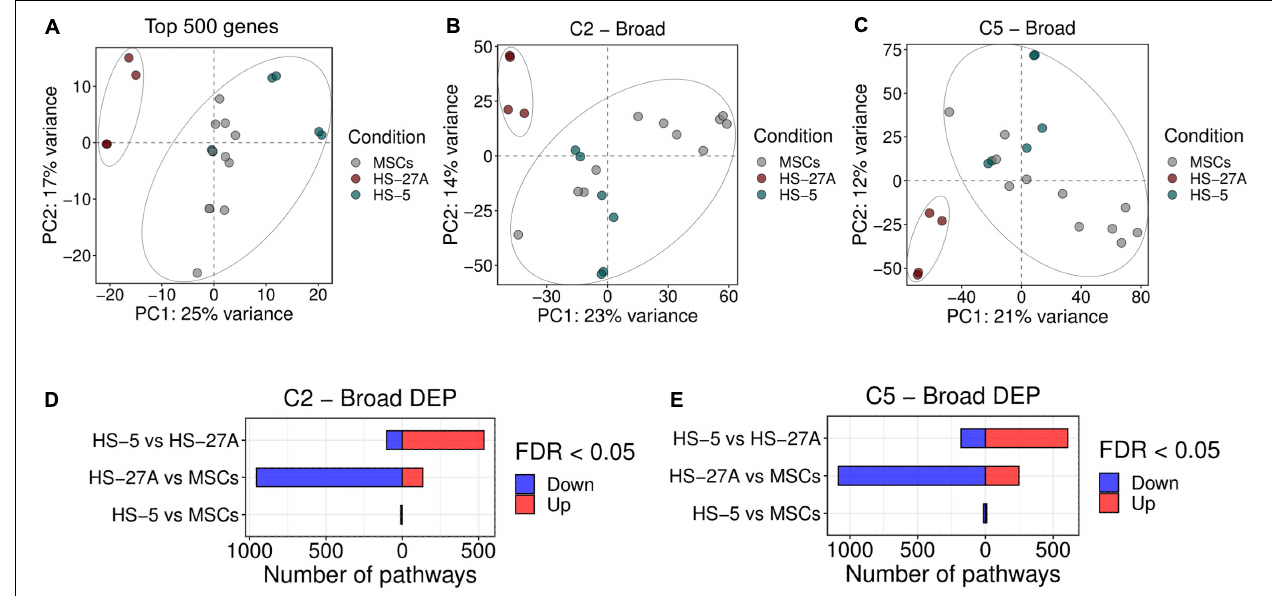
FIGURE 2 | Overall gene expression profile of primary MSCs, HS-5 and HS-27A cell lines. (A) Score plot of the first two PCs calculated following the application of PCA on top 500 genes expressed by primary MSCs, HS-5, and HS-27 cell lines. (B,C) Score plot of the first two PCs following the application of PCA on DEP included in C2 (B) and C5 (C) gene sets collections between primary MSCs, HS-5 and HS-27 cell lines. (D,E) Number of significantly down- and up-regulated pathways included in C2 (D) and C5 (E) gene sets collections between primary MSCs, HS-5, and HS-27 cell lines. ( n MSCs, HS-5, HS-27A = 11, 6, 4). PCs, principal components; PCA, principal component analysis; DEP, differentially expressed pathways.